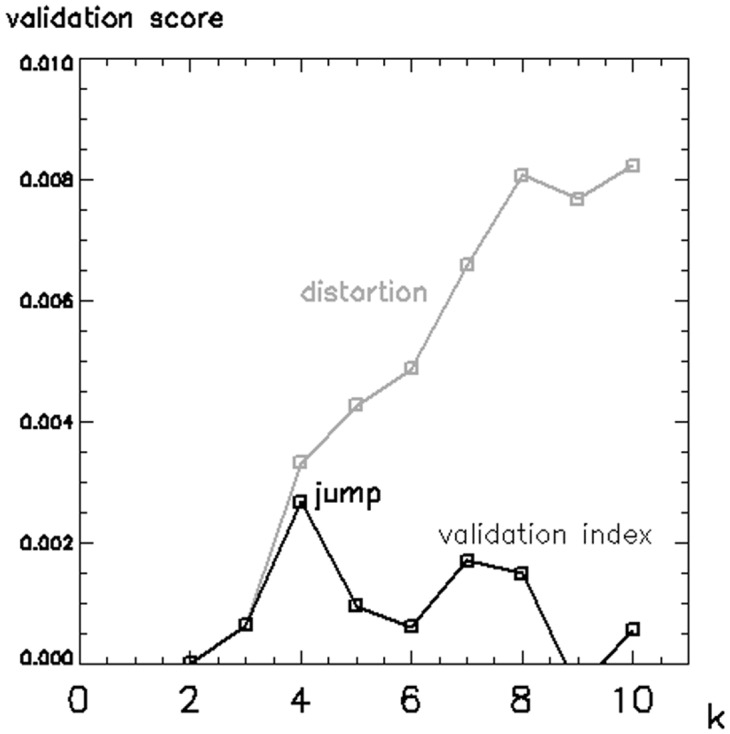
Cluster validation.Cluster validation curves for the range 2 ≤ k ≤ 10. The distortion curve (grey line) has a sharp rise in correspondence of the optimal number of clusters k = 4. The validation curve (black line) is produced by taking the difference between consecutive values of the distortion curve, and exhibits a “jump” in correspondence of k = 4.